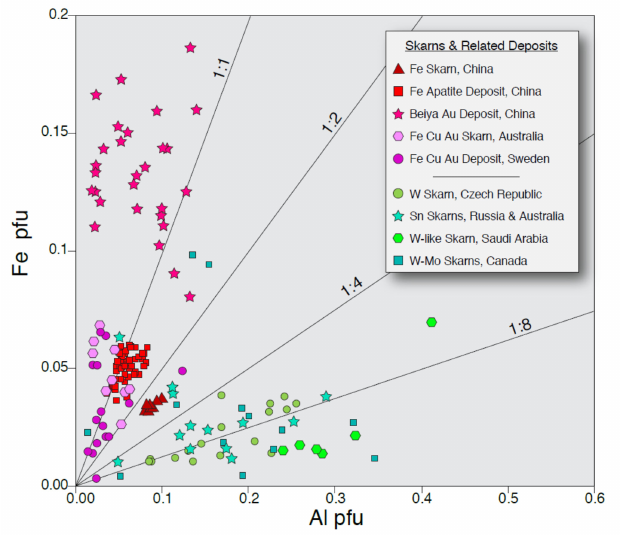
Figure 25. Fe versus Al in titanite from skarns and related ore deposits. Titanite from deposits rich in Fe, Cu, and Au (squares and red shades) plot at higher Fe/Al values (>1:3) than does titanite from deposits rich in W and Sn (circles and green shades, which have Fe/Al values (<1:4), except for a few data point exceptions. The data come from the following sources: